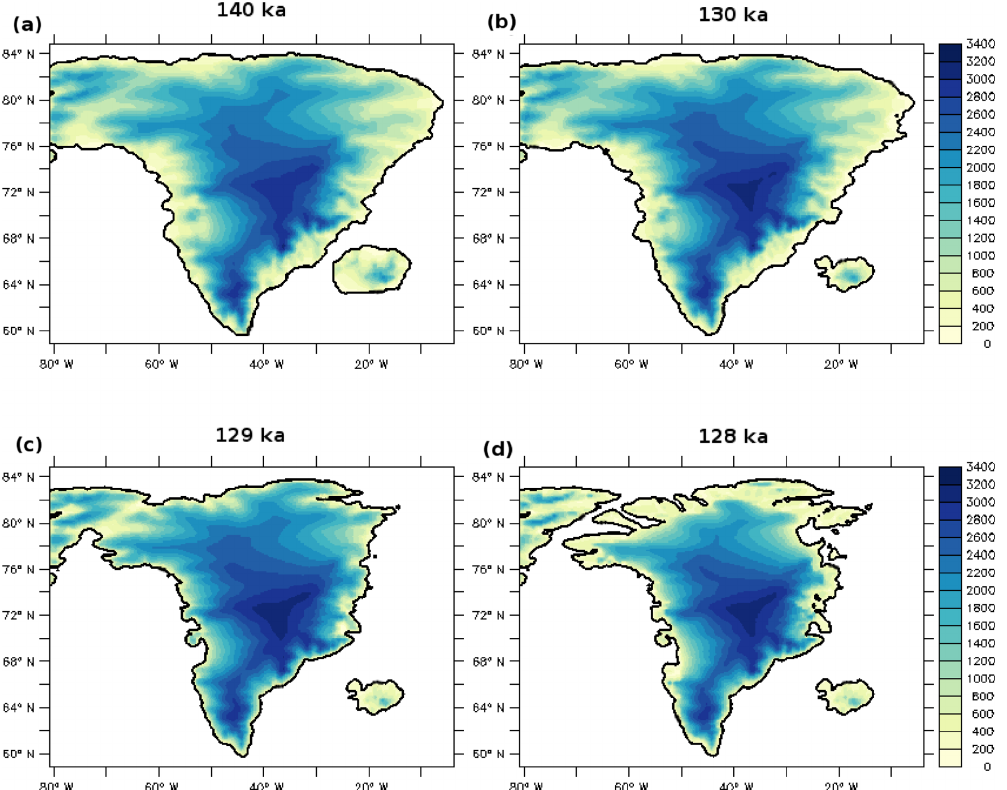
Figure 5. Greenland ice-sheet elevation (m) at (a) 140ka, (b) 130ka, (c) 129ka and (d) 128ka as simulated by the GSM (e.g. Tarasov et al., 2012). The 0 elevation contour is in black.